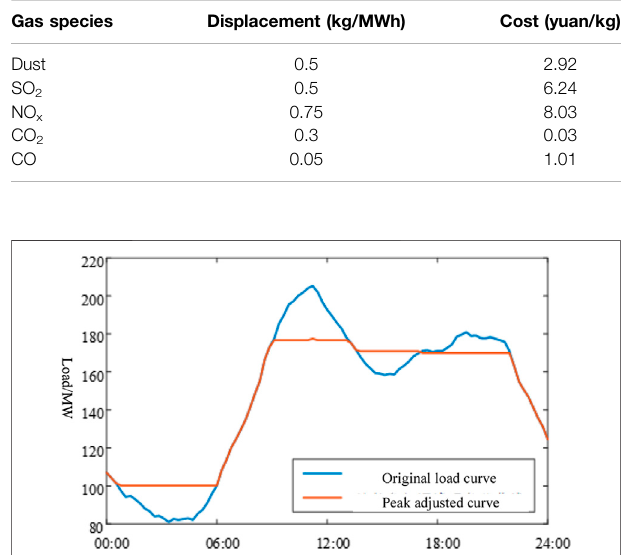
FIGURE 2 | Comparison diagram of post-peak load involving original load and energy storage.